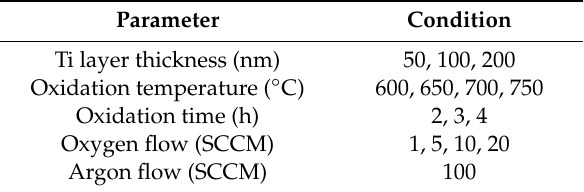
Table 1. Experimental condition tested for the synthesis of TiO 2 NWs.